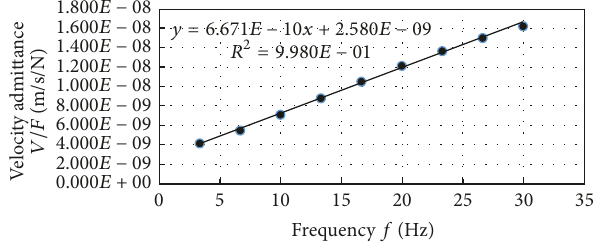
Figure 10: The linear fitting curve of low frequency curve of admittance curve.